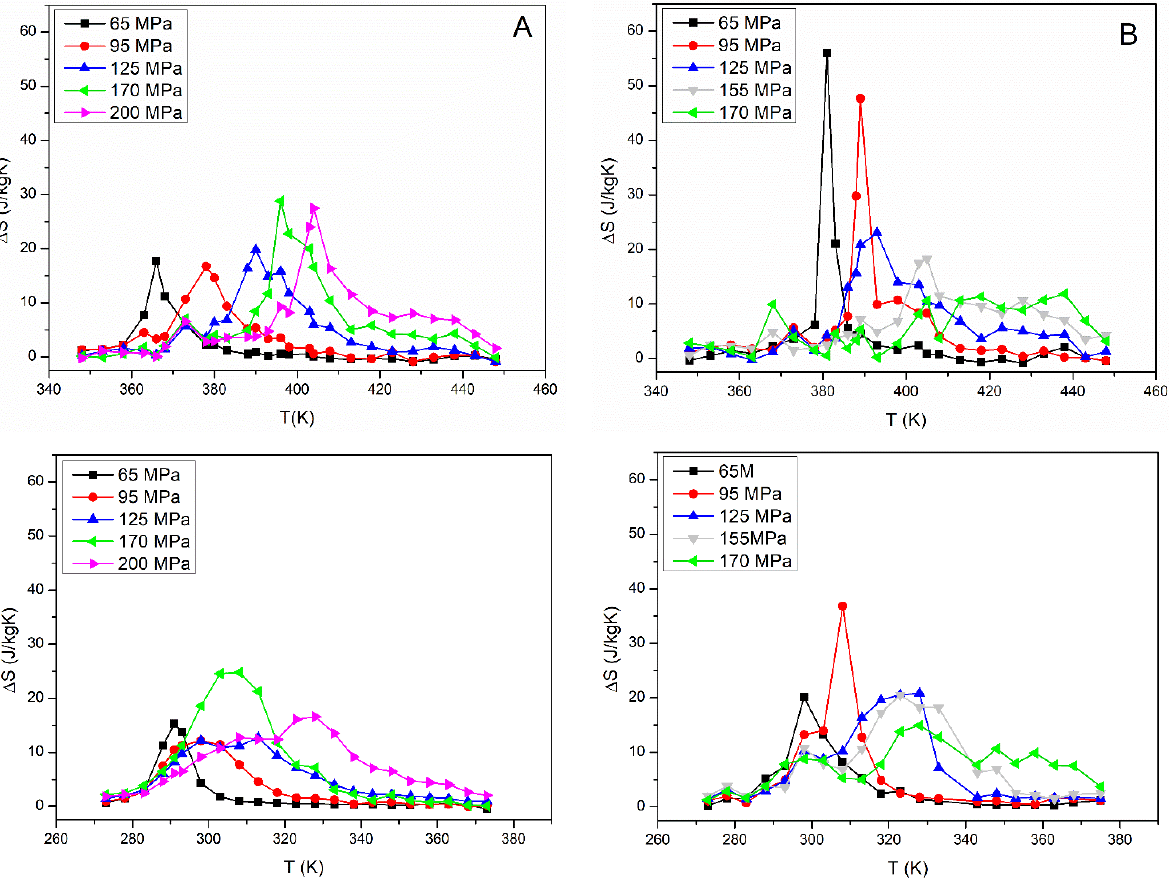
Figure 3. Value for ∆ S vs. T obtained by discrete integration from strain recovery curves in the heating ( top ) and cooling ( bottom ) parts for samples A ( A ) and B ( B ).